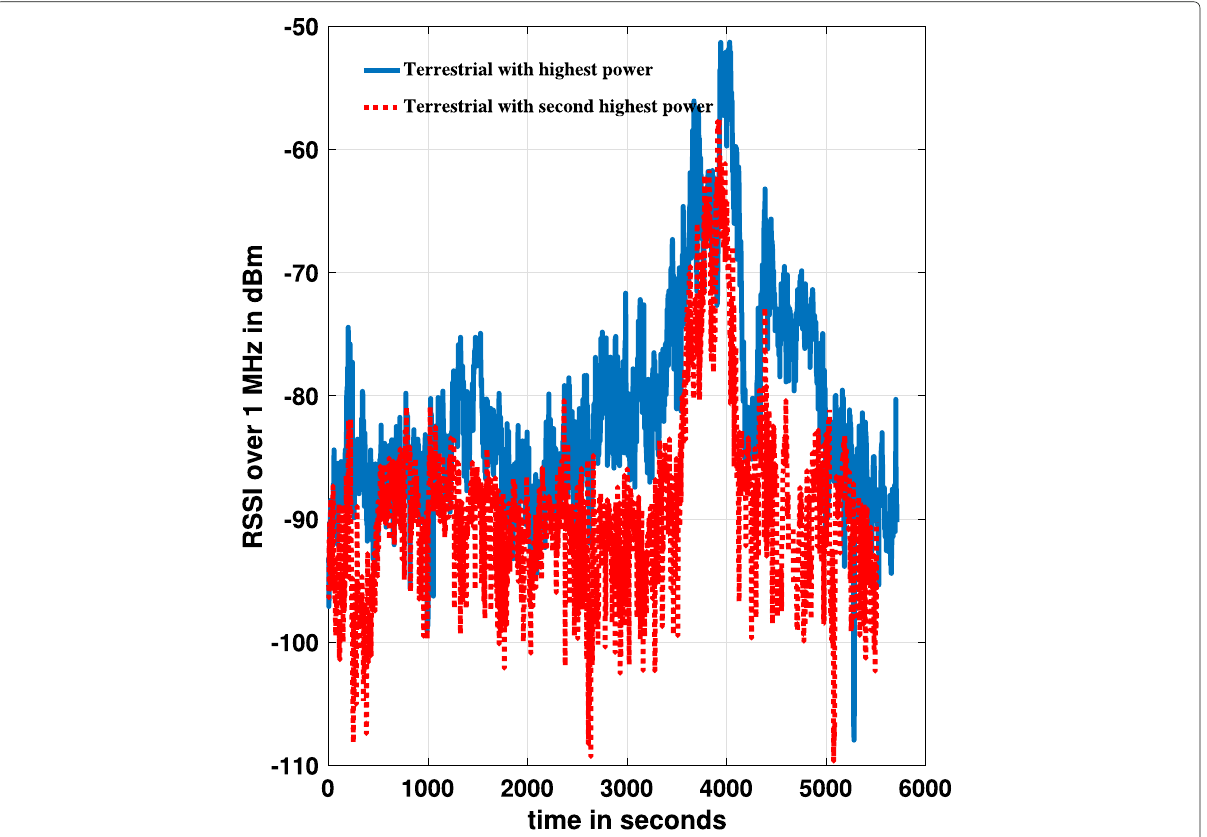
Fig. 16 RSSI from two terrestrial